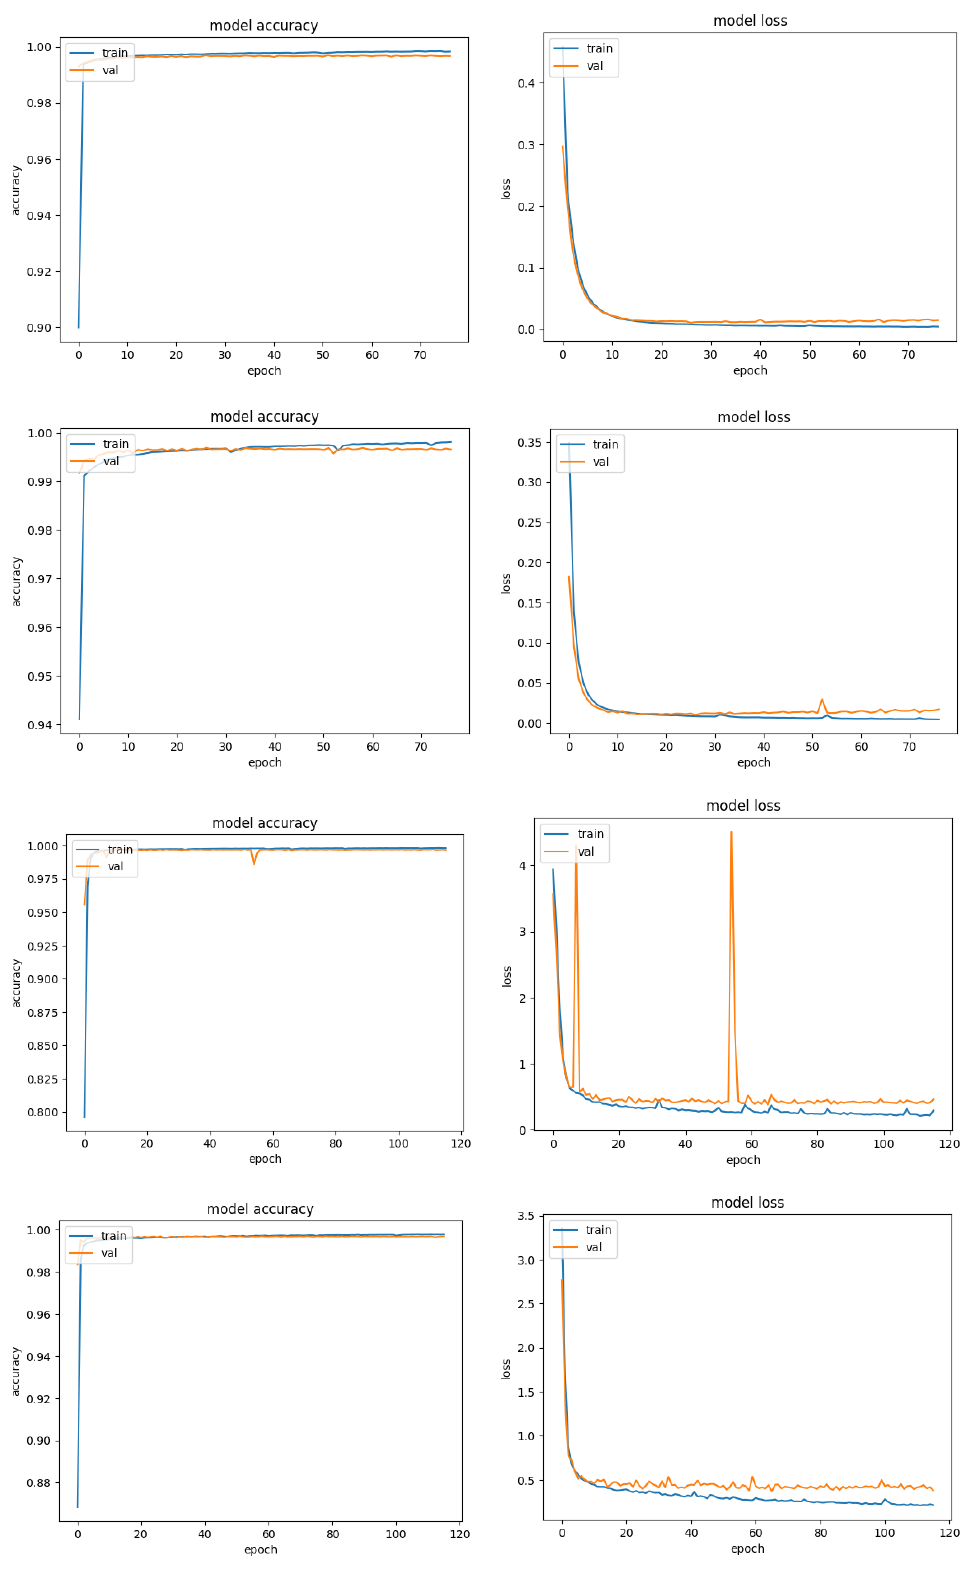
Figure 10. Accuracy and loss of the training and validation datasets per training epoch for UNet. First Row: baseline, BCE loss, trained on no patch. Second Row: baseline, BCE loss, trained with patches. Third Row: baseline, Jaccard loss, trained on no patch. Fourth Row: baseline, Jaccard loss, trained with